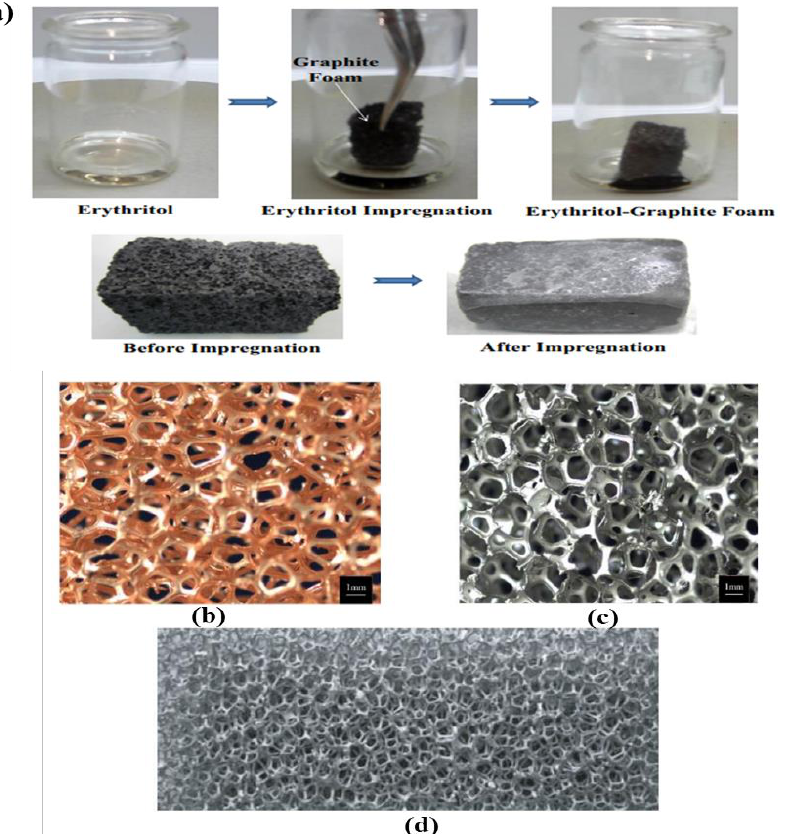
Figure 11. ( a ) Impregnation technique of erythritol–graphite composite foam preparation. Repro- duced with permission from [143]. Metal foams of: ( b ) copper, ( c ) nickel, and ( d ) aluminum [83].